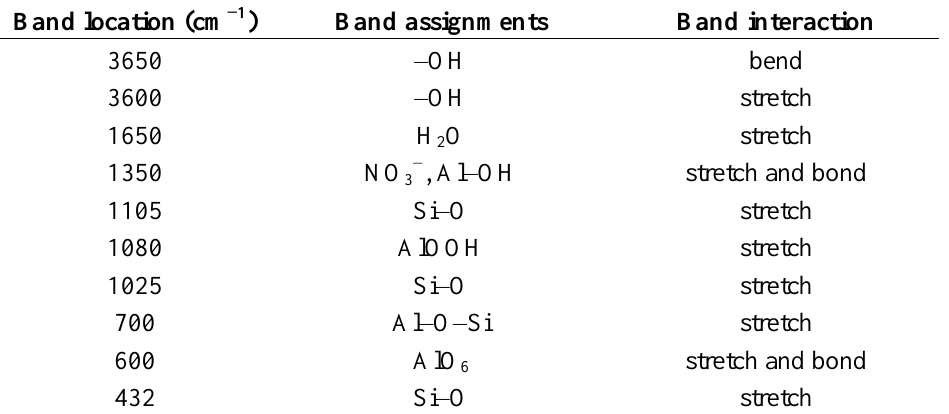
Table 1. Peak assignments in the residue FT-IR